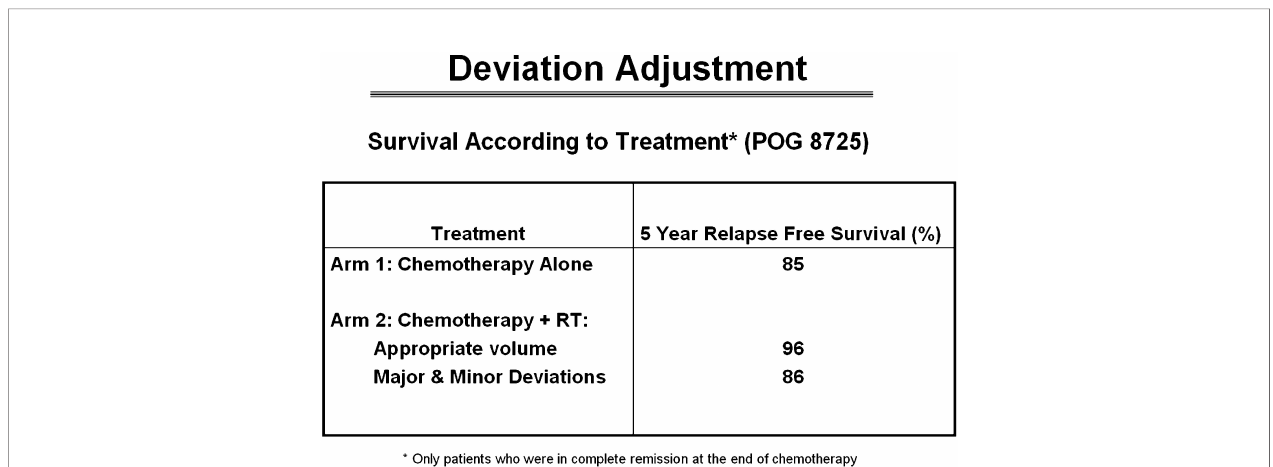
FIGURE 1 | Non-protocol compliant radiation therapy had equal survival to patients treated with chemotherapy alone. Patients with protocol compliant radiation therapy had improved survival which was statistically signi fi cant